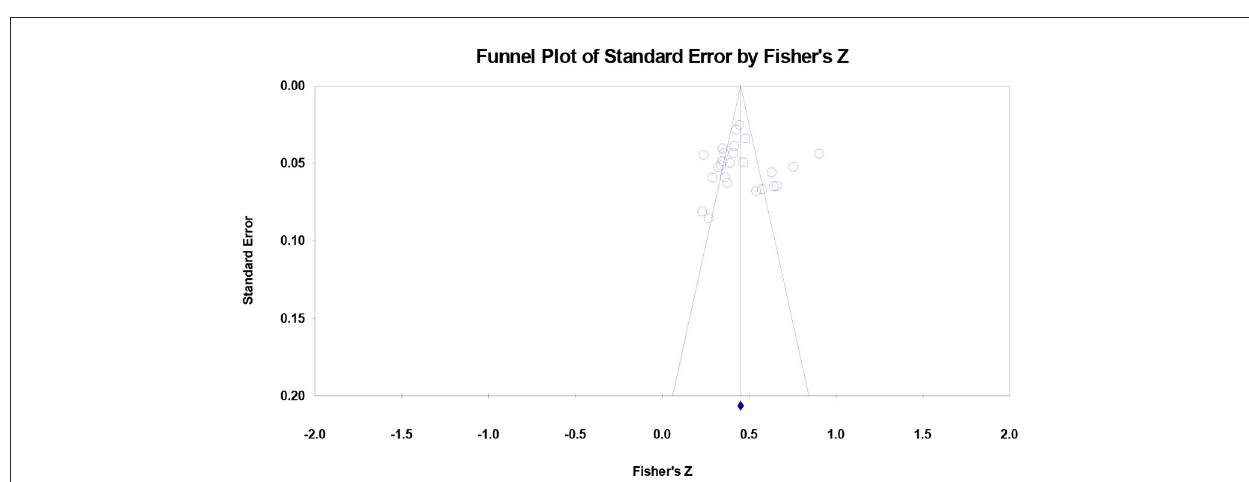
FIGURE5 Funnel plot of effect sizes for the association of decent work with career capabilities. Note that the mean of combined outcome variables was used.